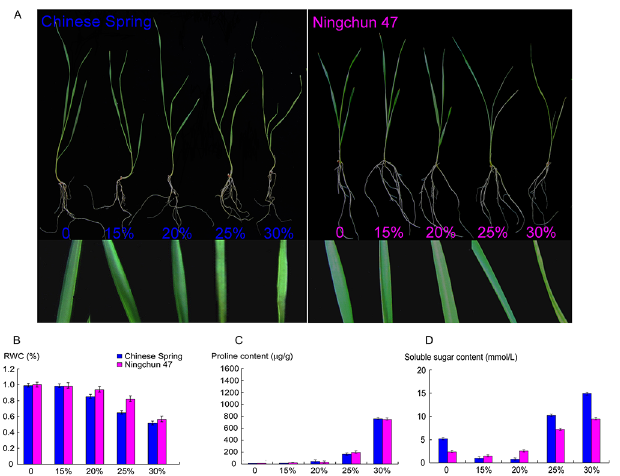
Fig 1. Morphological and physiological changes in seedlings of two wheat ( Triticum aestivum L.) cultivars, ‘ Chinese Spring ’ (CS) and ‘ Ningchun 47 ’ (NC47), during 48 h of PEG-mediated drought stress. (A) Morphological changes of wheat seedlings in response to different PEG6000 concentration treatments. (B) Leaf relative water content (RWC) analysis. (C) Proline content analysis. (D) Soluble sugar content analysis.